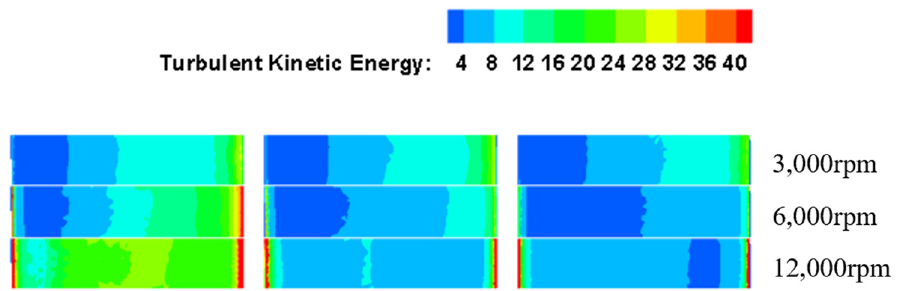
Figure 13. Turbulent kinetic energy cloud diagram of cross section in tooth cavity with 5 mm pitch at different rotating speeds.